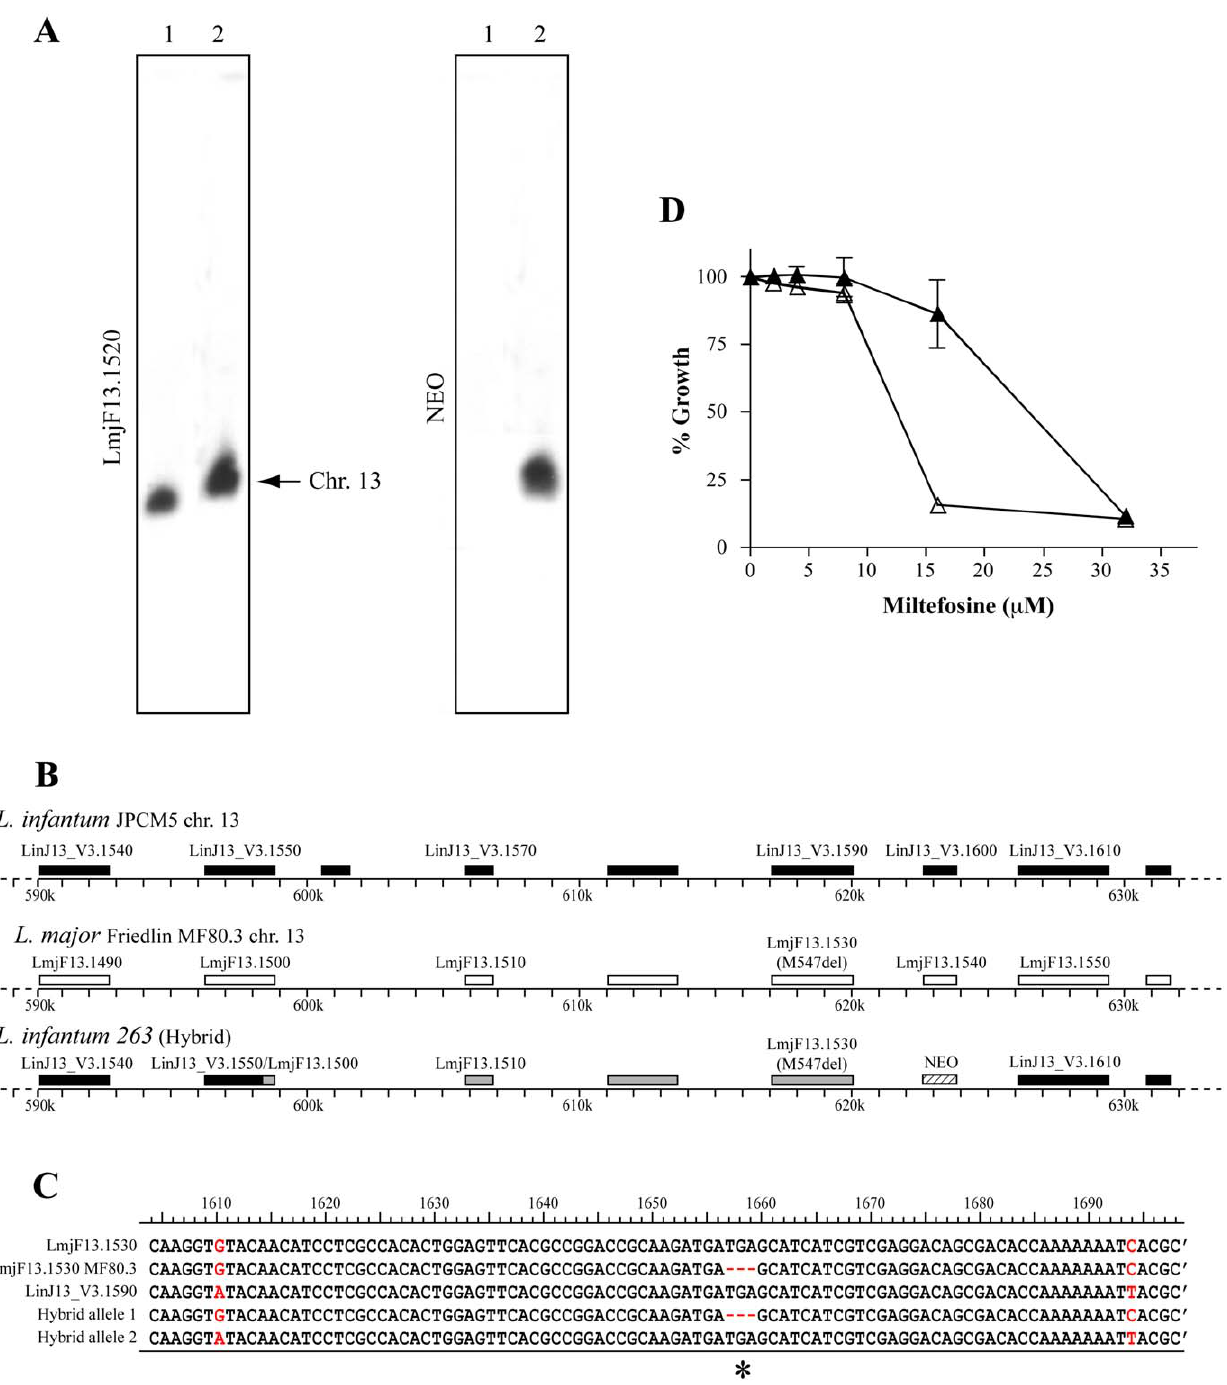
Figure 5. Cross species functional phenotypic transfer. (A) L. infantum 263 WT parasites were transfected with total gDNA derived from L. major Friedlin LmMF80.3 D LmjF 13.1540 ::NEO/LmjF13.1540 (Figure S1C). Chromosome sized blots were hybridized with probes specific for the LmjF13.1520 gene (left panel), located just upstream of the MT gene on chromosome 13, or for the NEO marker (right panel). Lane 1, L. infantum 263 WT; Lane 2, L. infantum hybrid for L. major LmMF80.3 gDNA at its MT locus. (B) Schematic map of the genomic region encompassing the MT gene of L. infantum JPCM5 (black boxes), L. major Friedlin MF80.3 (white boxes), and the hybrid region (grey boxes). The genomic regions exchanged in the L. infantum 263 hybrid were mapped by sequencing the genes located in the vicinity of the integrated NEO marker (Table S11) and by whole genome short reads next generation sequencing. (C) Sequence of the MT genes of L. major Friedlin (LmjF13.1530), L. major Friedlin MF80.3 [19] and L. infantum JPCM5 WT (LinJ13_V3.1590) respectively. The MT gene from L. infantum hybrids was amplified and cloned into the pGEM-T-easy vector. The analysis 10 independent E. coli clones identified L. infantum WT and L. major MF80.3 alleles in similar proportions indicating that the L. infantum hybrid is heterozygous at its MT locus. The asterisk (*) indicates the deletion of three nucleotides (M547del) present in L. major Friedlin MF80.3 [19] and sequence in red are polymorphisms between L. major and L. infantum . (D) L. infantum 263 WT parasites ( D ) and L. infantum 263 hybrid for LmMF80.3 D LmjF13.1540 ::NEO/ LmjF13.1540 at their MT locus ( m ) were grown in increasing concentrations of miltefosine and their EC 50 values determined. The mean of three independent experiments is indicated. A statistical significance was observed by Student’s t-test (p , 0.05). doi:10.1371/journal.pntd.0001817.g005 PLOS Neglected Tropical Diseases |